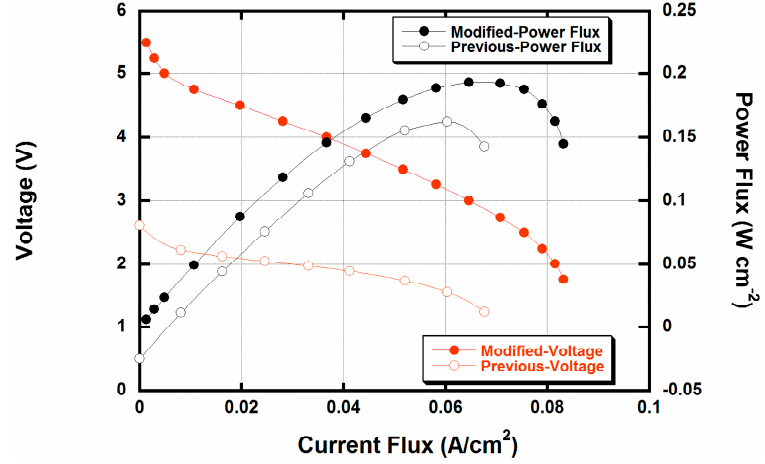
Figure 11. Compared with previous designs of fuel cell stack